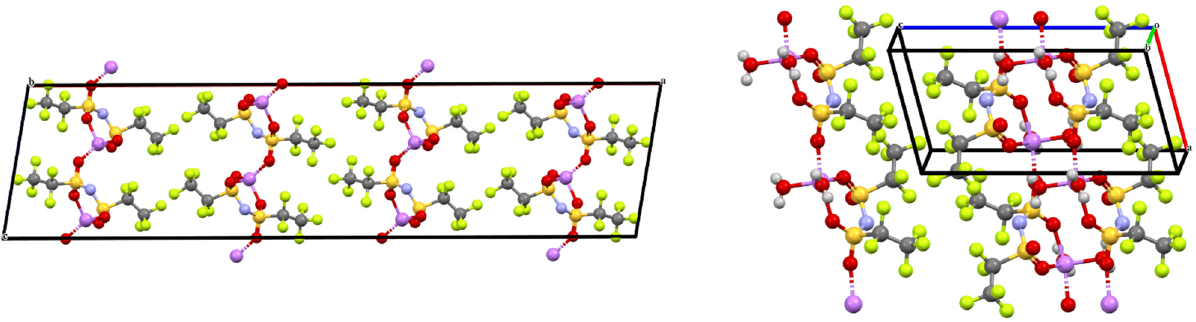
Figure 4. Packing diagrams for [Li{BETI}] ( left ) and [Li{BETI}(H 2 O) 2 ] ( right ). Alternating layers of fluorine and oxygen atoms are prominent features of both structures. Unit cells are shown for references.